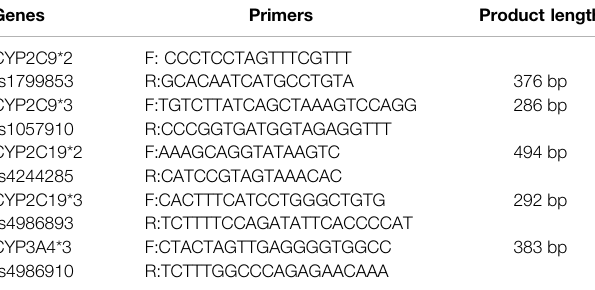
TABLE 1 | The primers of genes.